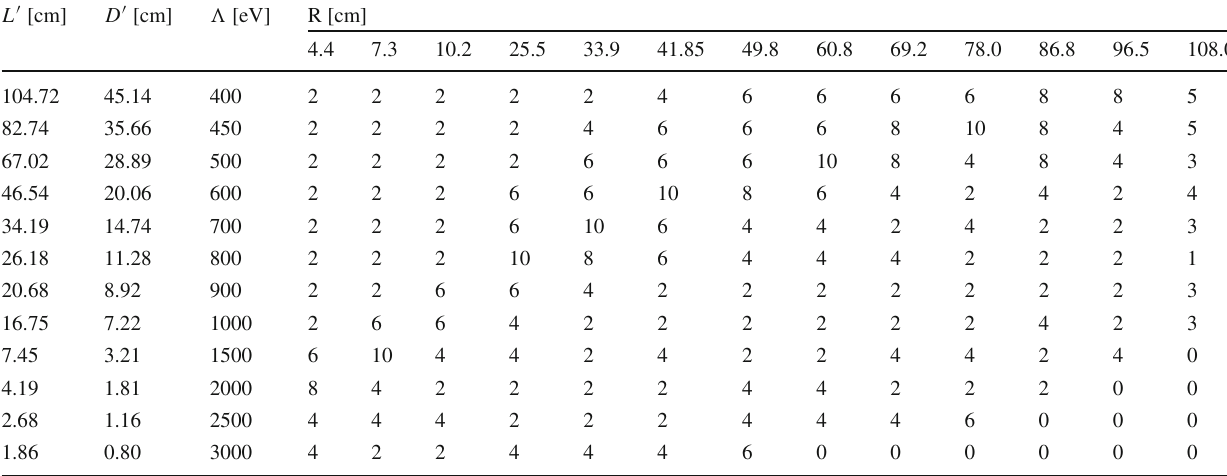
Table 2 Number of hits in different cylindrical barrels of CMS tracker induced by the quirk pair within 25 ns. We also provide the corresponding L (cid:12) and D (cid:12) values in the left part of the